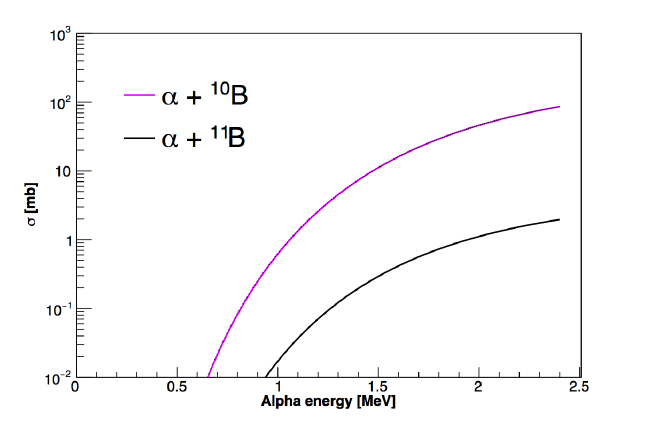
Figure 2: Total cross-section of α + 10 , 11 B reactions calculated by Talys-1.9 [5]